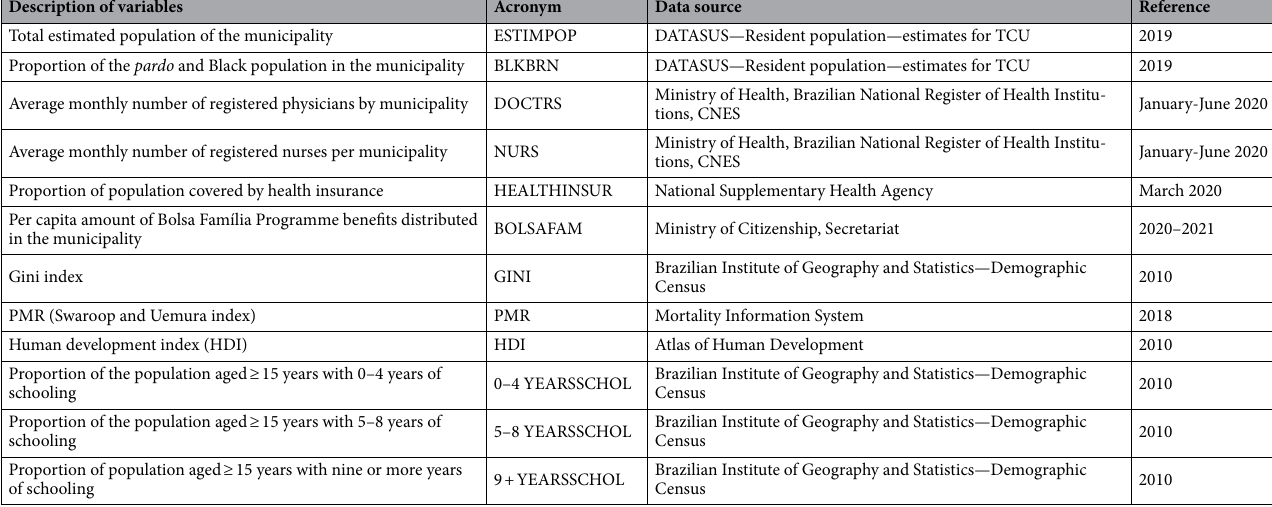
Table 2. Study covariates, data source, measures, and year of